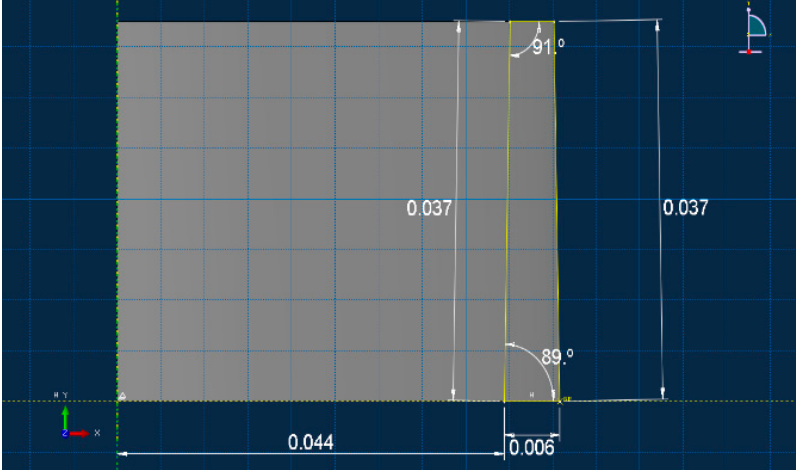
Figure 10. The slot geometry dimensions (m).